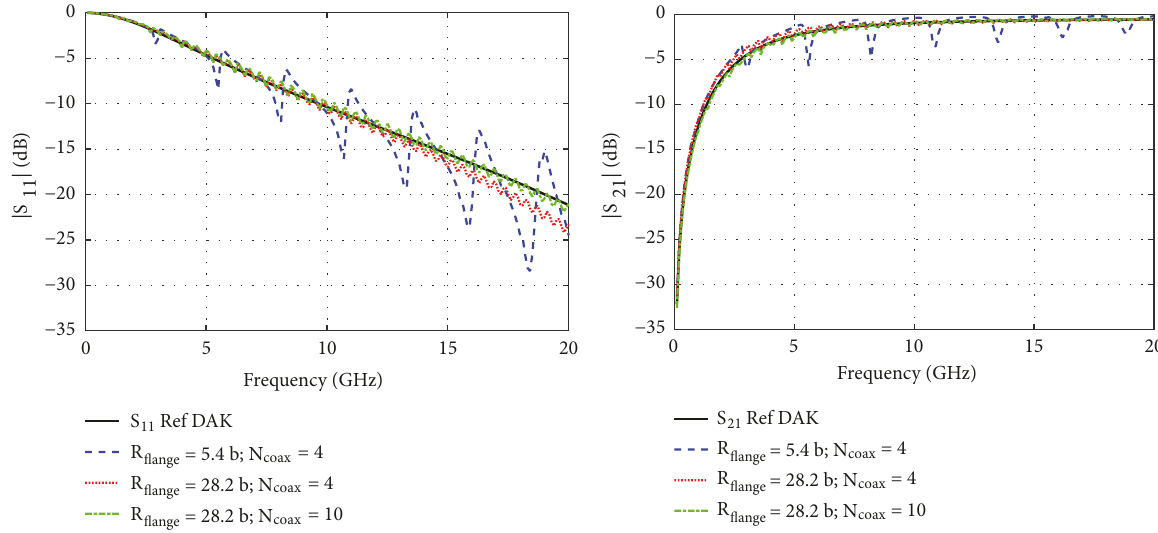
Figure 16: Magnitude (dB) of S 11 and S 21 for model B with TEM and TM 0 flange size, and number of modes (thickness d= 0.2 mm, R